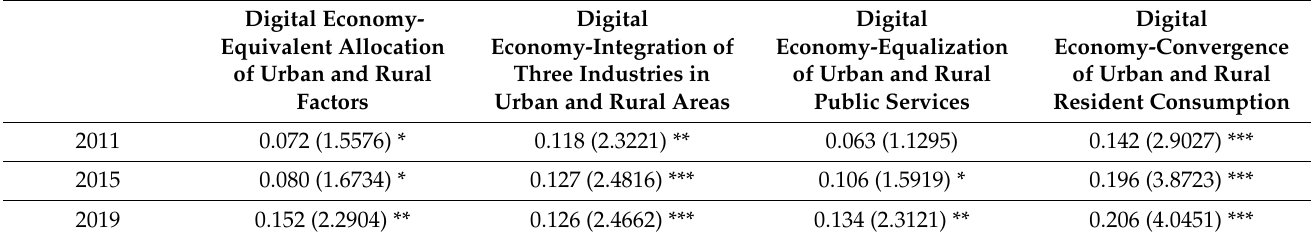
Table 3. Bivariate Global Moran’s I statistics of the digital economy and urban-rural